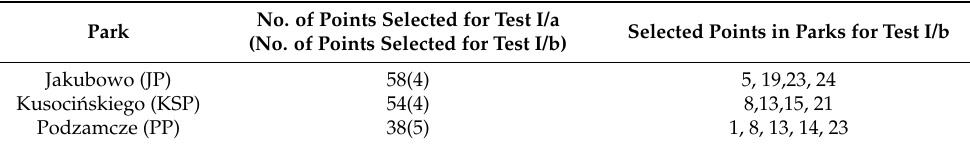
Table 2. Numbers of characteristic points selected for Test I/a, and I/b. No. of Points Selected for Test I/a Park (No. of Points Selected for Test